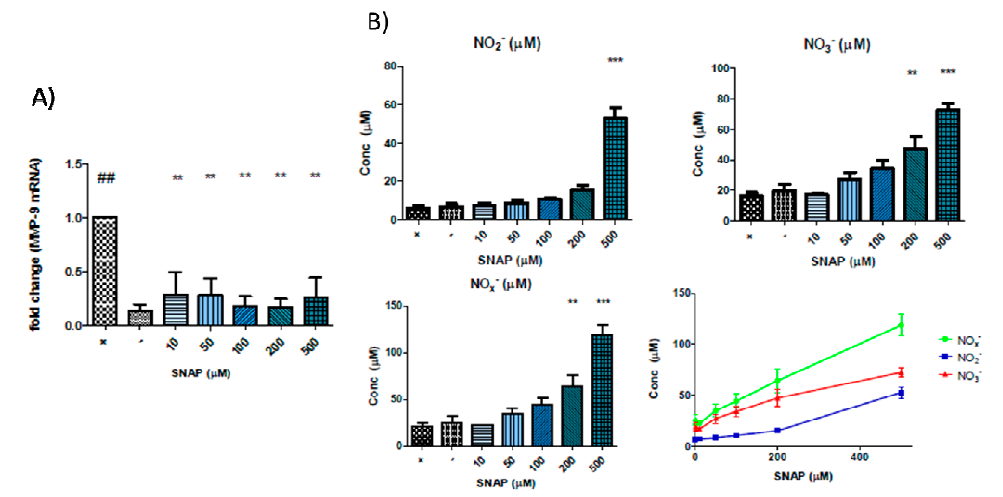
Figure 4. ( A ) SNAP significantly reduced MMP-9 mRNA at di ff erent concentrations tested in cytokine-stimulated Caco-2 cells: ## p < 0.01 vs. unstimulated Caco-2 cells (negative control); ** p < 0.01 vs. cytokine-stimulated Caco-2 cells (positive control). ( B ) Measurements of nitrate and nitrite concentrations as breakdown products of NO by the Griess assay on the conditioned media of Caco-2 cells after 24 h of co-incubation with SNAP and proinflammatory cytokines TNF- α and IL-1 β . Top left pane shows the nitrite concentration, top right pane shows the nitrate concentration, bottom left pane shows the combined reduced NO groups and bottom right shows the linear correlations of SNAP concentrations versus the concentration of measured NOx − species. (** p < 0.01 vs. negative control; *** p < 0.001 vs. negative control).